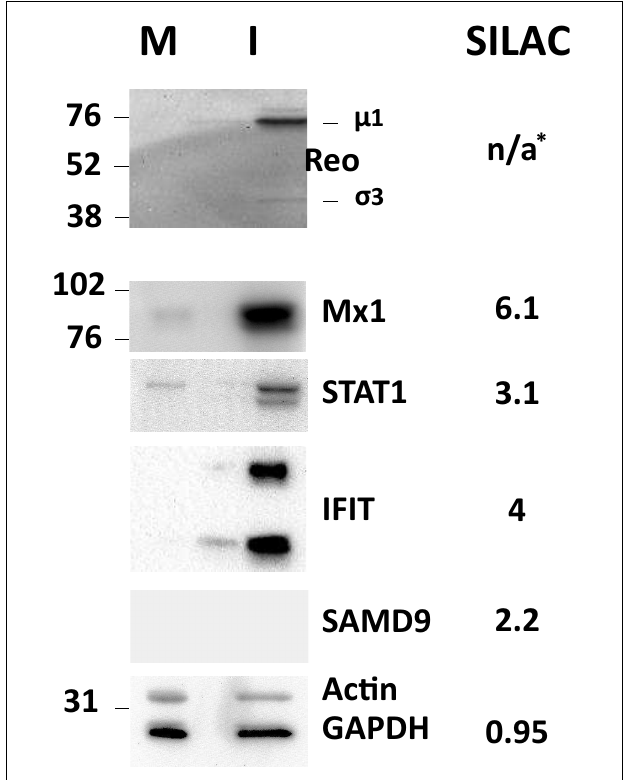
FIGURE 4 |Western blot validation of experimentally determined SILAC ratos. HeLa cells were harvested and lysed with 0.5% NP-40 detergent, nuclei removed, and cytosolic fractions dissolved in SDS electrophoresis sample buffer. Proteins were resolved in 10% mini-SDS-PAGE, transferred to PVDF, and probed with indicated antibodies. Bands were visualized, and intensities measured, with an Alpha Innotech FluorChem ® Q Multi Image ® III instrument. Molecular weight standards are indicated at left and SILAC-measured ratios are indicated on the right. ∗ , No viral proteins measured by SILAC as these are absent from mock-infected